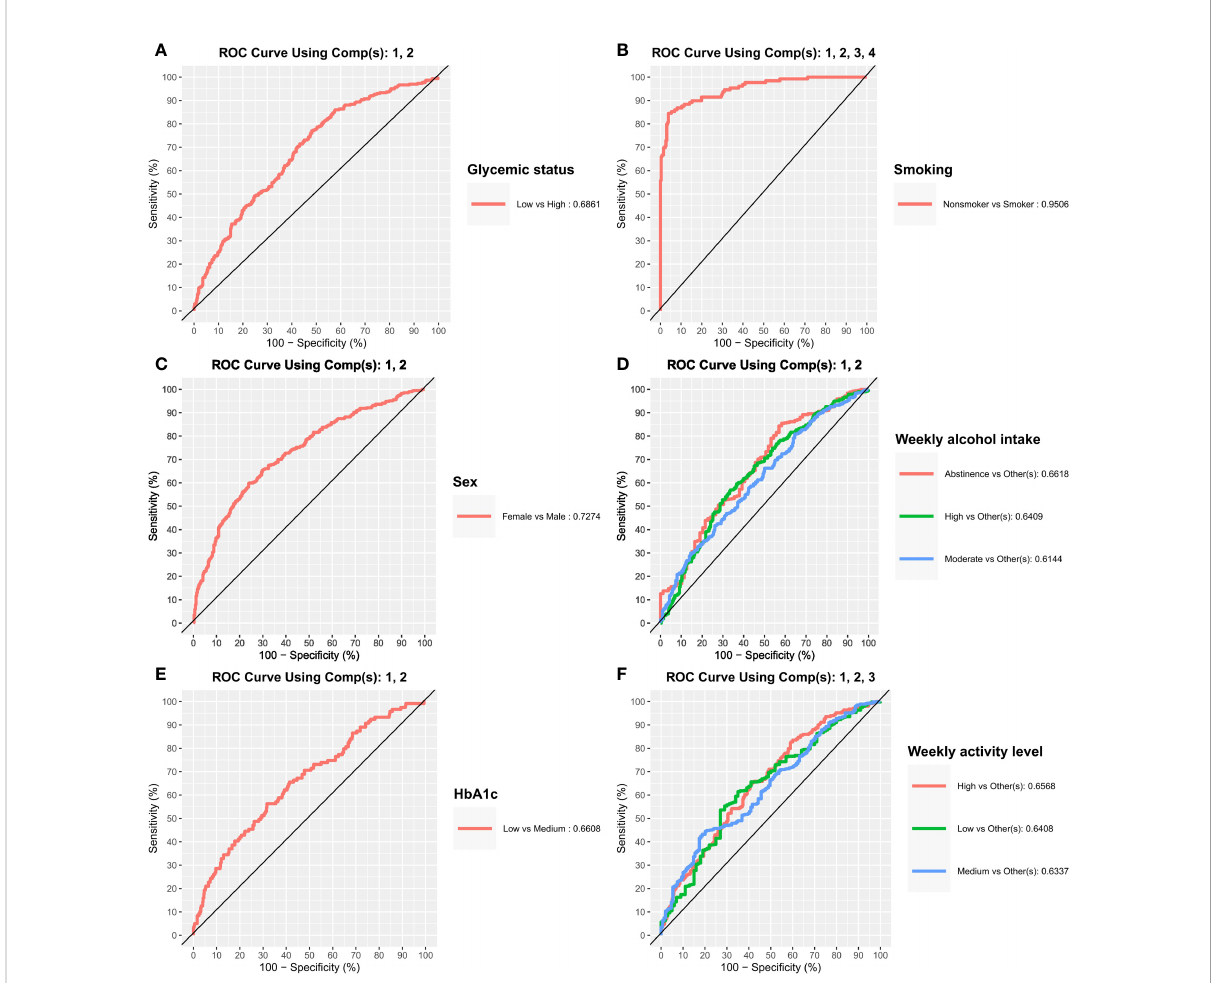
FIGURE 5 Classi fi cation potential of the salivary microbiota. Receiver Operating Characteristics (ROC) curves from sparse partial least squares discriminant analysis where used to assess classi fi cation of the different groups. Area under the curve (AUC) were used to quantify the performance of the classi fi er. (A – F) glycemic status, smoking, sex, weekly alcohol intake, HbA 1c , and weekly activity